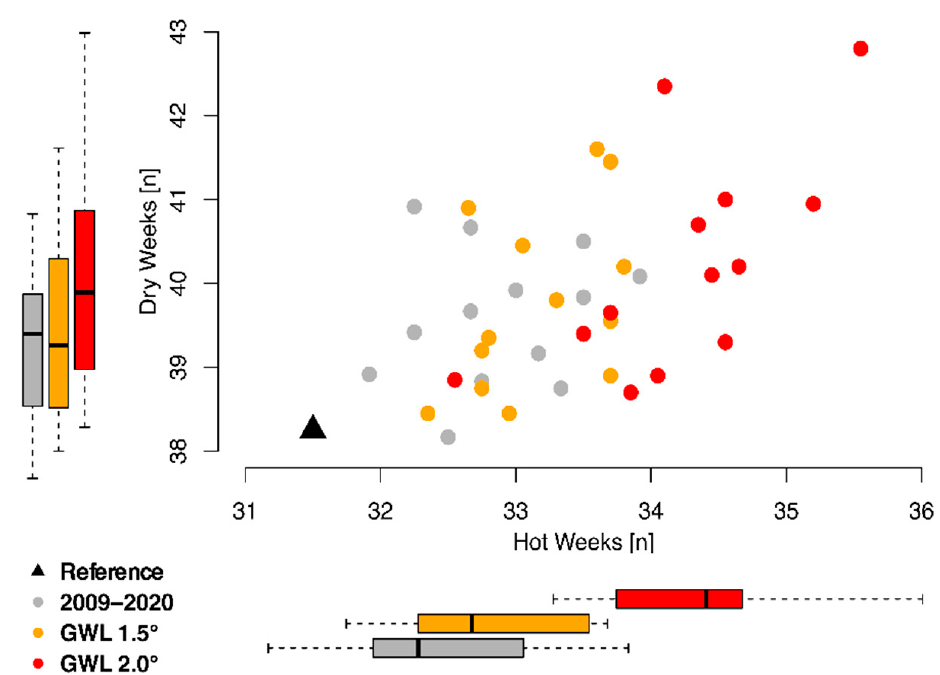
Figure 4. Annual average number of hot (temperature > 19 °C) and dry (rainfall < 6 mm) weeks under current and future climate. The corresponding number of weeks are shown for the reference data (ERA5, black triangle), as well as the applied climate models for the reference period 2009–2020 (grey) and the two Global Warming Level (GWL) targets of 1.5 °C (orange) and 2.0 °C (red). Outside boxplots refer to the spread of the climate models for hot and dry weeks (x and y-axis) separately under the different time periods/warming levels.